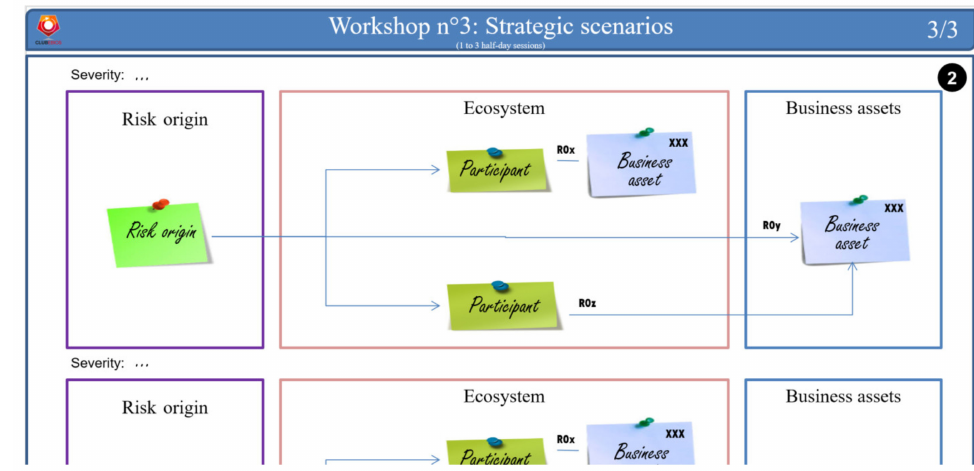
Figure 12. Ob é risk datasheet—workshop n ◦ 3: strategic scenarios (graphical